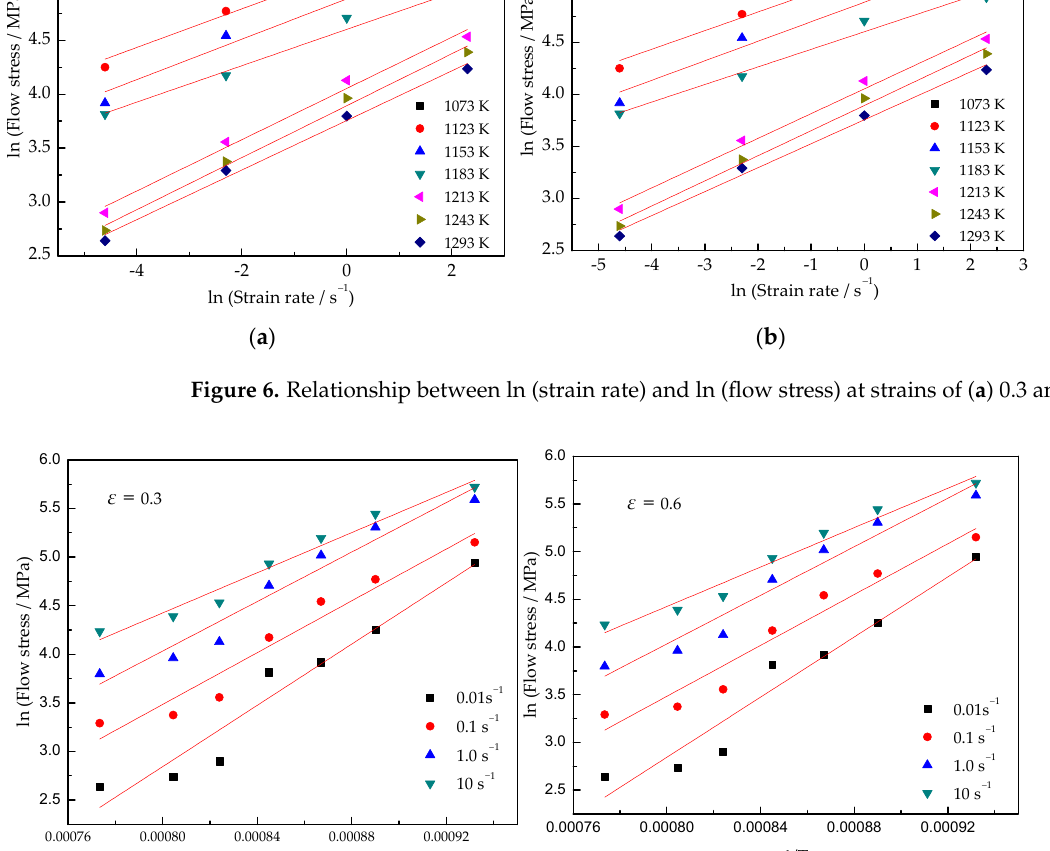
Figure 7. Relationship between 1/T and ln (flow stress) at strains of ( a ) 0.3 and ( b ) 0.6. There is no strain term in the Arrhenius equation. However, the strain has an obvious influence on the flow stress, as shown in Figure 4, so it is very necessary to show the strain term in the flow stress model. By plotting the experimental data, it is found that there is also a linear relationship between σ ln and ε ln , as shown in Figure 8. Considering the influence of strain, the flow stress is expressed by the following formula: